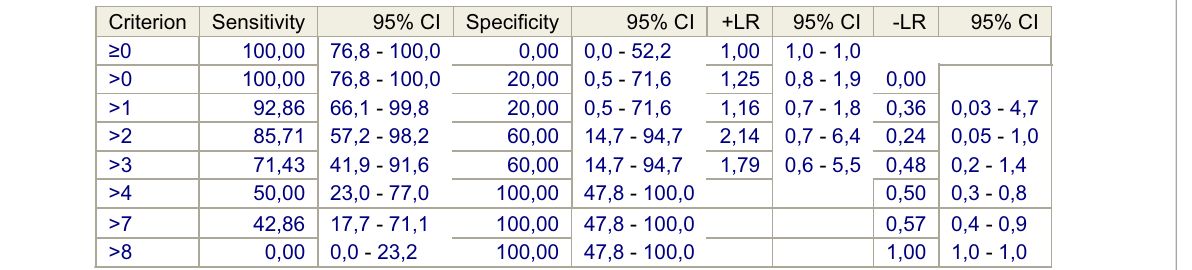
Fig. 4 Receiver operative characteristic (ROC) curve for EVLW/kg